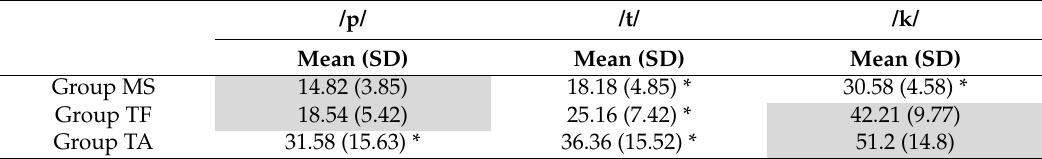
Table 2. Intergroup comparisons for all three voiceless stops in Spanish.